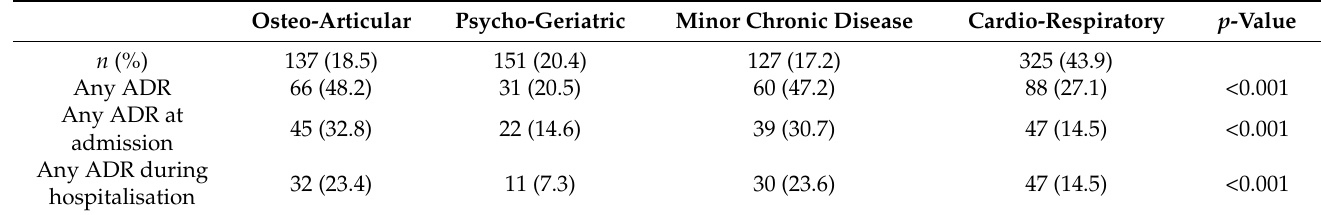
Table 3. Presence of any ADR in relation to the assigned multimorbidity clusters.